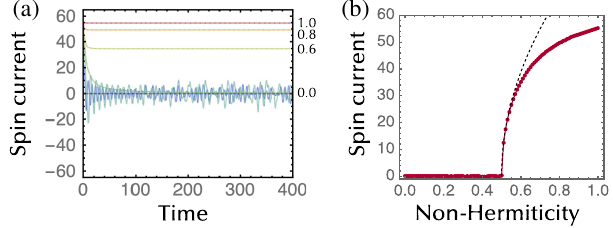
FIG. 13. Spin current in the symplectic Hatano-Nelson model with periodic boundaries ( L ¼ 100 , J ¼ 1 . 0 , Δ ¼ 0 . 5 ). The initial state is prepared as Eq. (24). (a) Time evolution of the spin current for γ ¼ 0 . 0 (black dashed curve), 0.2 (blue curve), 0.4, 0.5, 0.6 (green curves), 0.8 (orange curve), and 1.0 (red curve). (b) Spin current for the steady state as a function of non-Hermiticity γ . The black dashed curve is the fitting result